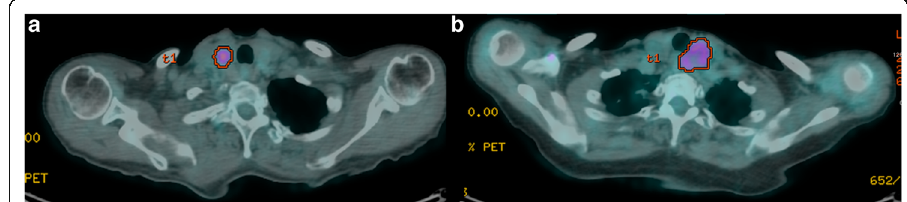
Fig. 1 Examples of pattern of [ 18 F]FDG uptake at PET/CT images of 2 thyroid incidentalomas identified by the region of interest (red circle). Moderate [ 18 F]FDG uptake was observed in a benign nodule (TIR2 at cytology) of the right thyroid lobe ( a ) and in a differentiated thyroid cancer (TIR3 at cytology) of the left thyroid lobe ( b